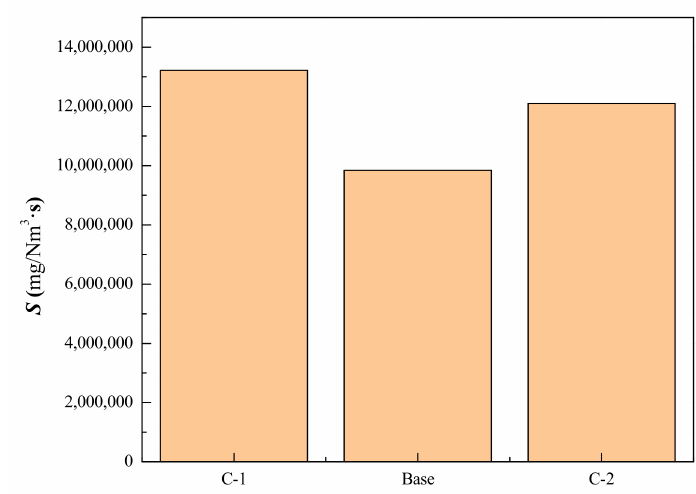
Figure 9. Influences of the ratio of water in the sintering mixture on CO emission. (The ratios of water: C-1 = 7; Base = 7.5; C-2 = 8).